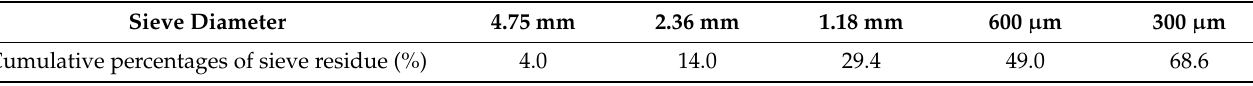
Table 5. Sea sand particle